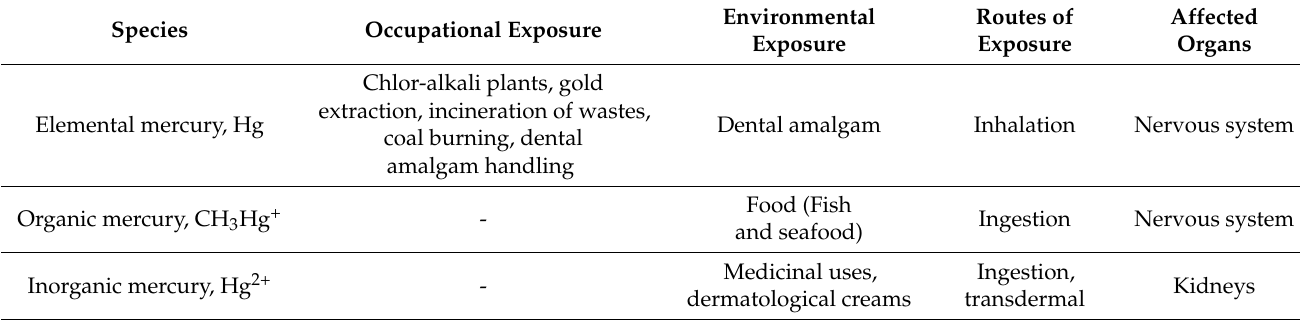
Table 1. Some representative sources of exposure of the different forms of mercury, and the main affected organs [21]. Species Occupational Exposure